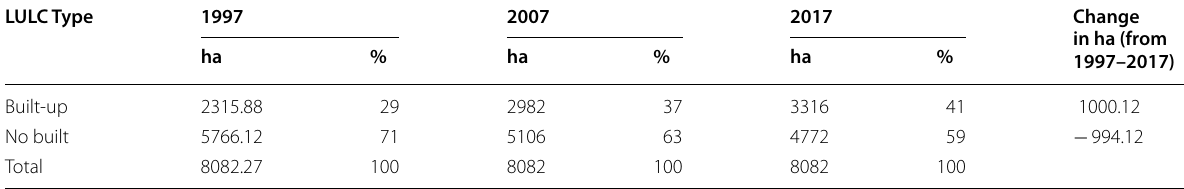
Table 4 Change detection of informal settlement for the year 1997, 2007, and 2017 LULC